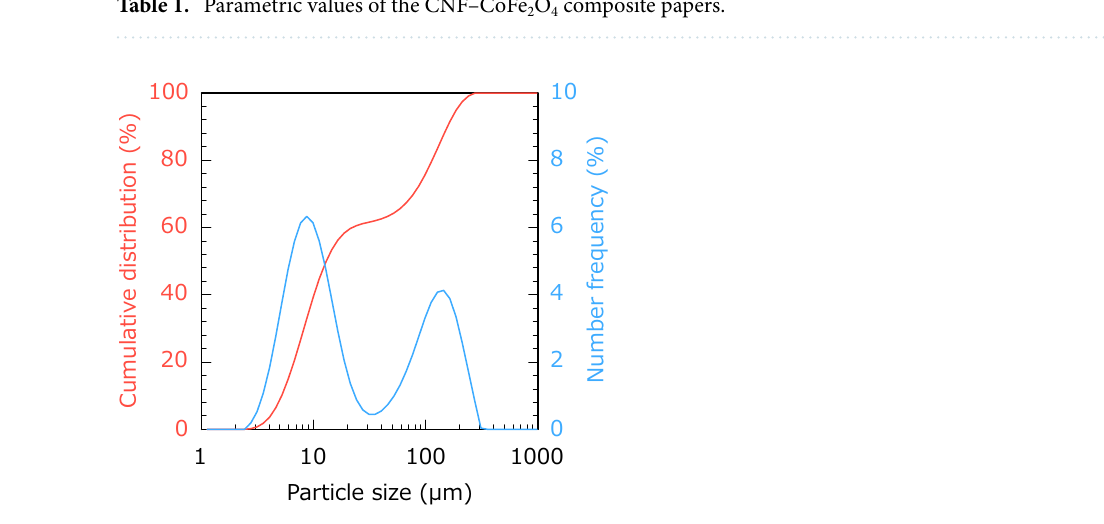
Figure 2. Size distribution of the CoFe 2 O 4